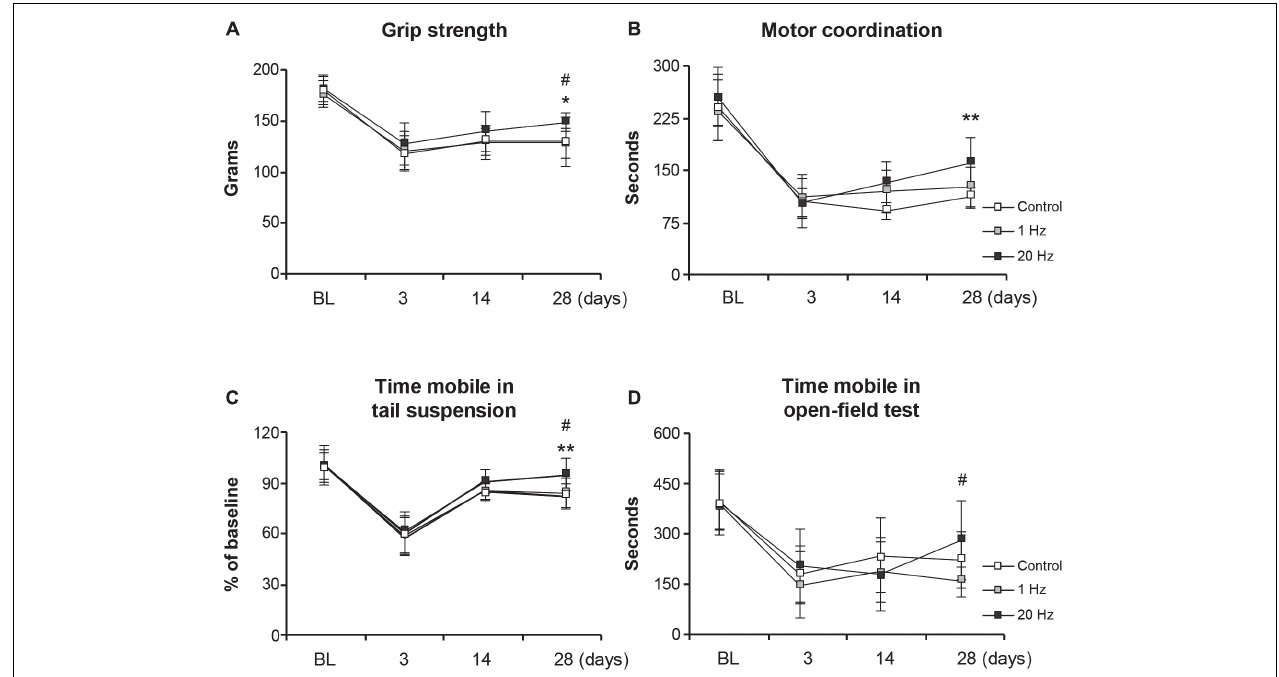
FIGURE 5 | 20 Hz rTMS promotes post-ischemic grip strength and motor coordination, thus reducing depression. Evaluation of post-ischemic recovery of grip strength (A) , motor coordination (B) , depression (C) , and spontaneous activity (D) . Data were evaluated by one-way ANOVA followed by LSD tests. Data are presented as mean ± SD values ( n = 12 mice/group). ** p < 0.01/* p < 0.05 compared with control, # p < 0.05 compared with 1 Hz